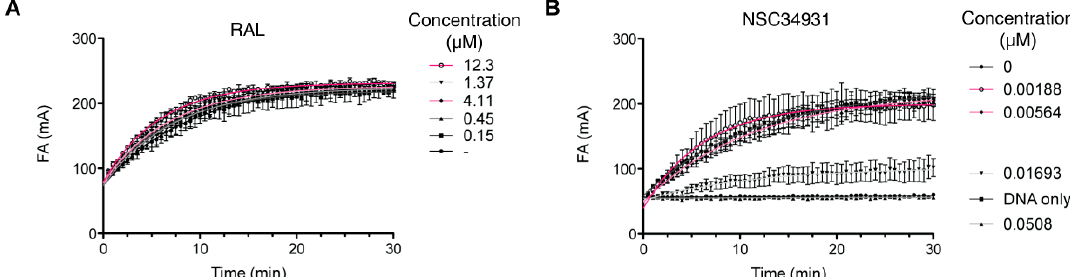
Figure 4. Measurement of IN-DNA binding over time using fluorescence anisotropy. Effect of RAL ( A ) and NSC34931 ( B ) on the DNA-binding property of IN. A three-fold serial dilution of RAL from 12.3 to 152 nM and from 50.8 to 1.88 nM for NSC34931 was used. In addition, controls with DMSO (0 µM) or without IN (DNA only) were included. Data represent the mean of three independent experiments.